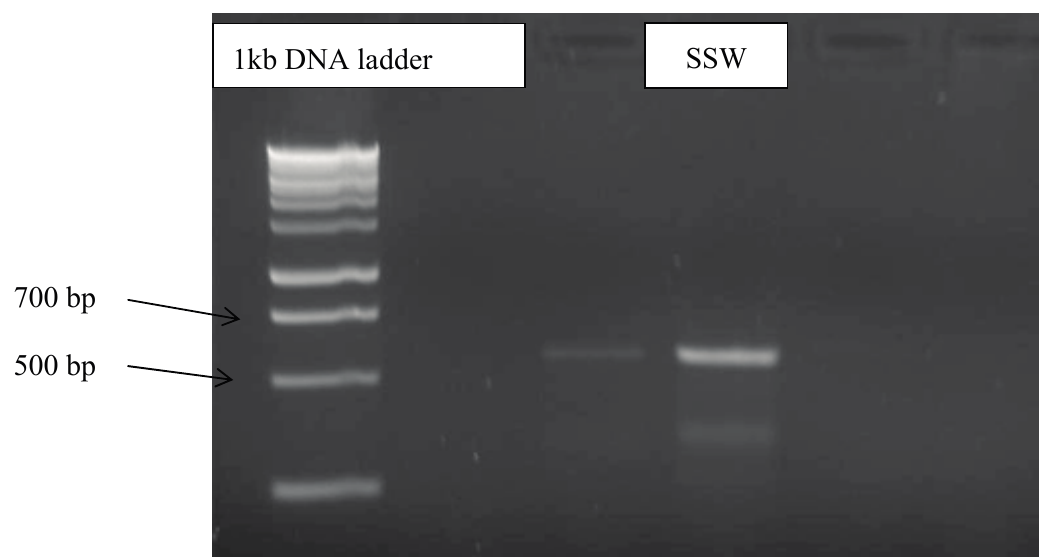
Figure 5. Gel electrophoresis of SSW strain PCR